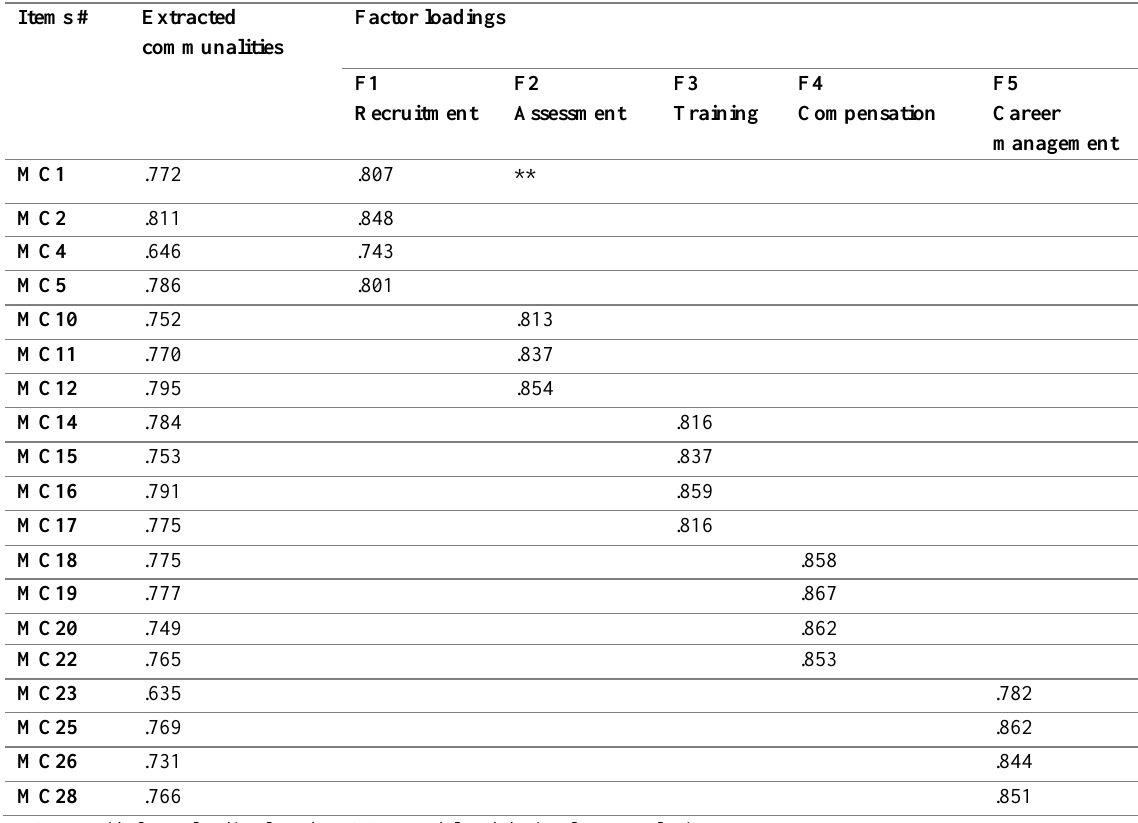
Table 3: The results of factor analysis